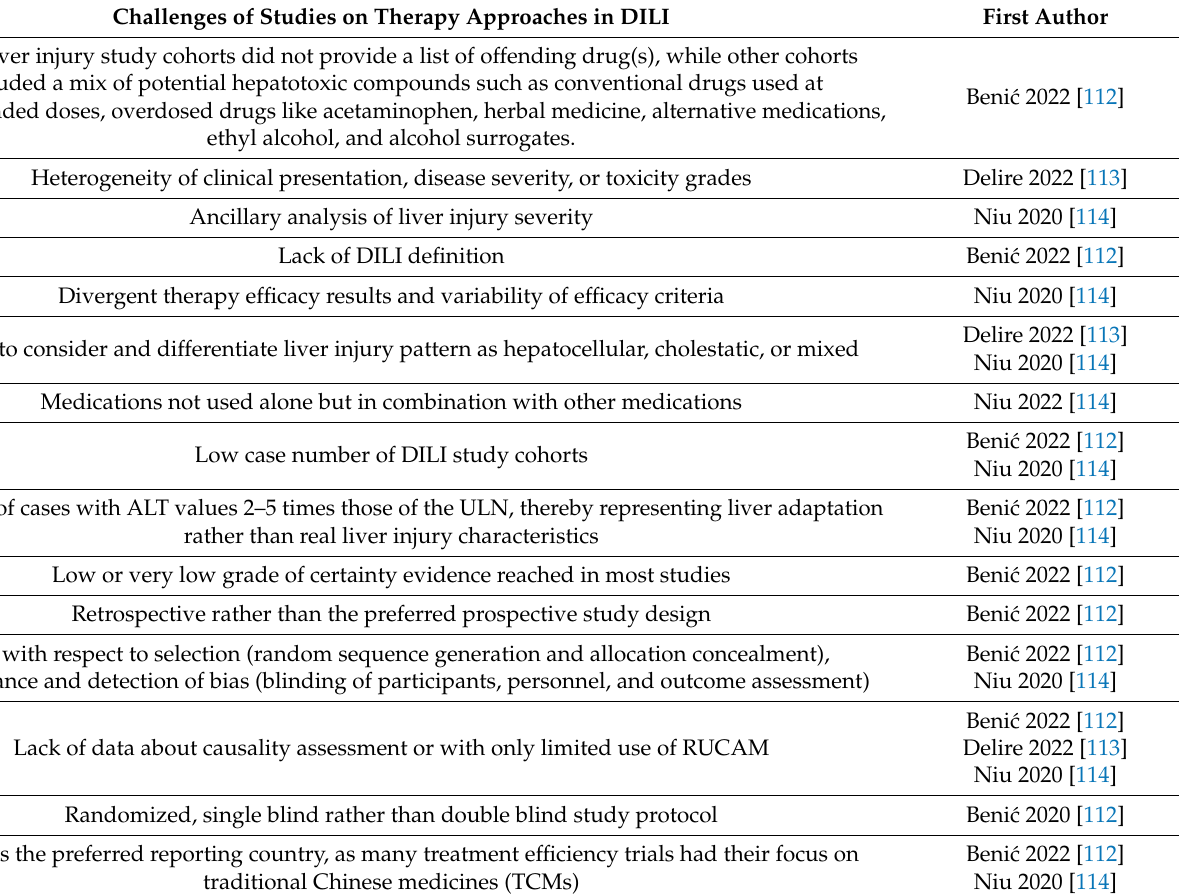
Table 4. Challenges of studies on therapy in